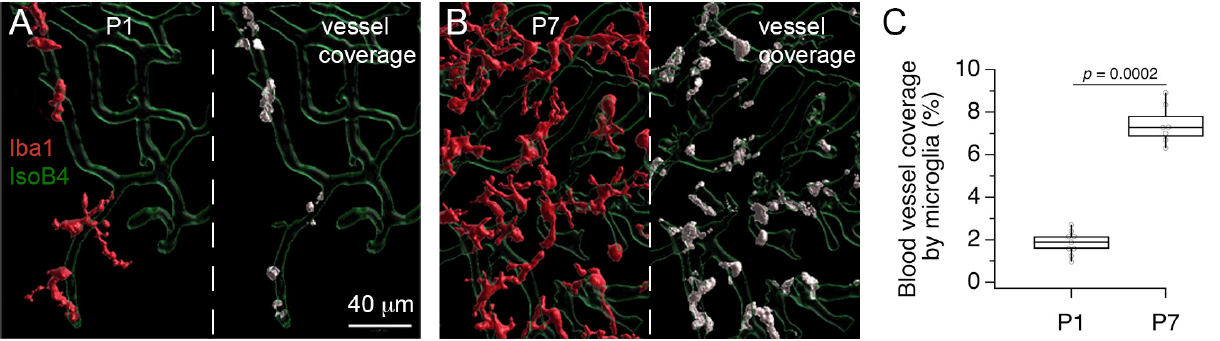
Figure 6. Increase in microglia vessel coverage in the MNTB. ( A ) 3D rendering after image segmentation shows microglia (maroon) and vessel (green) profiles in the MNTB at P1 (left). Coverage voxels between microglia and vessels are shown in white (right). ( B) 3D rendering shows microglia and vessel profiles in the MNTB at P7 (left). Note the numerous covearge voxels between microglia and vessels (right). ( C ) Percent microglia vessel coverage at P1 and P7.